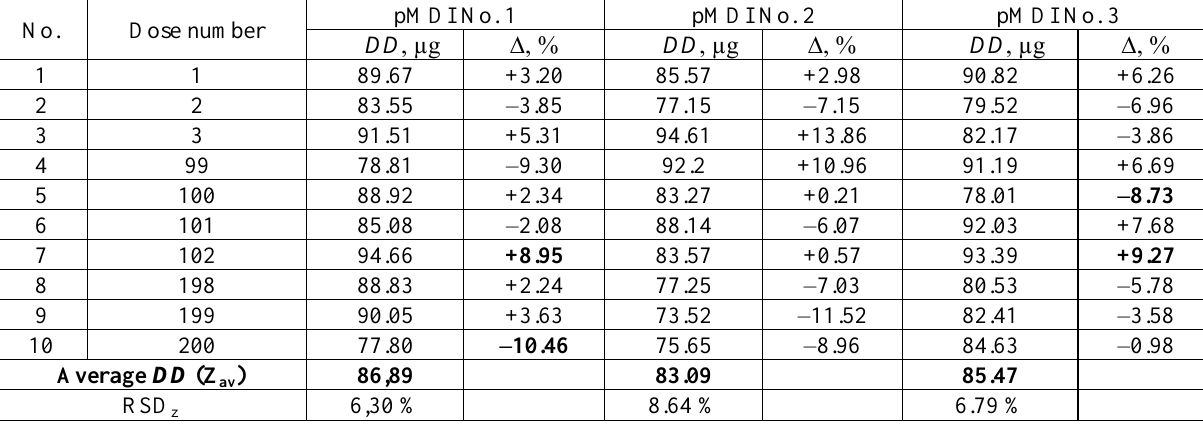
The results of the tests in regard to delivered dose (DD) and uniformity of delivered dose for the pMDIs